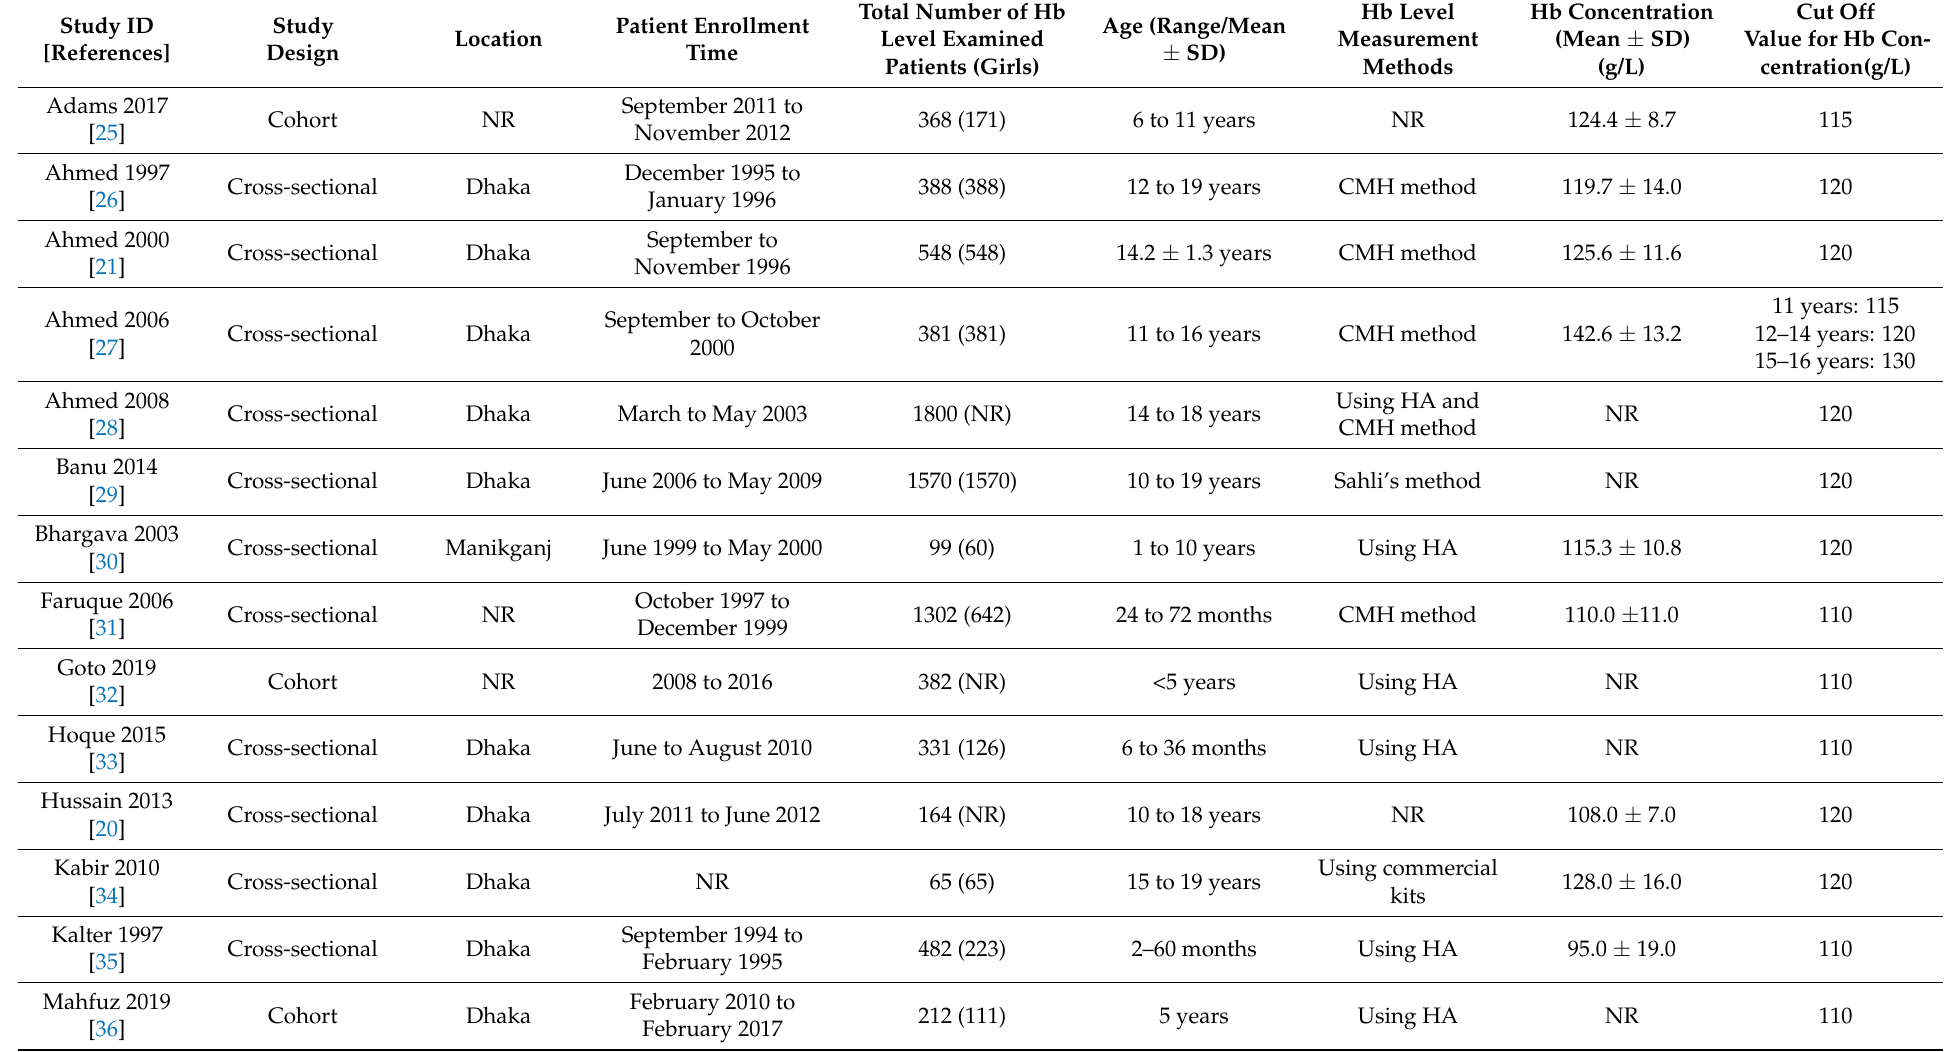
Table 1. Major characteristics of included